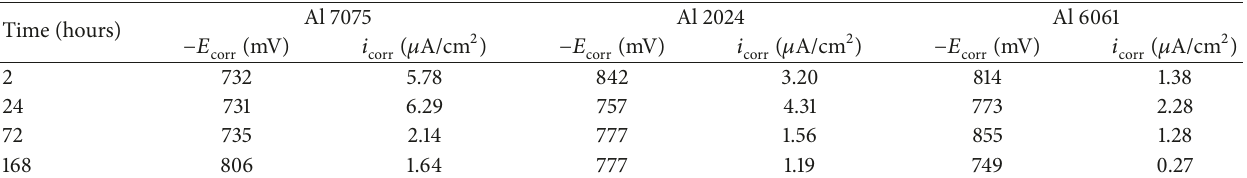
Figure 8: Potentiodynamic polarization curves of Al alloys in the Red Sea water at different time interval. Table 4: Potentiodynamic polarization parameters of Al alloys in the Red Sea water at different immersion